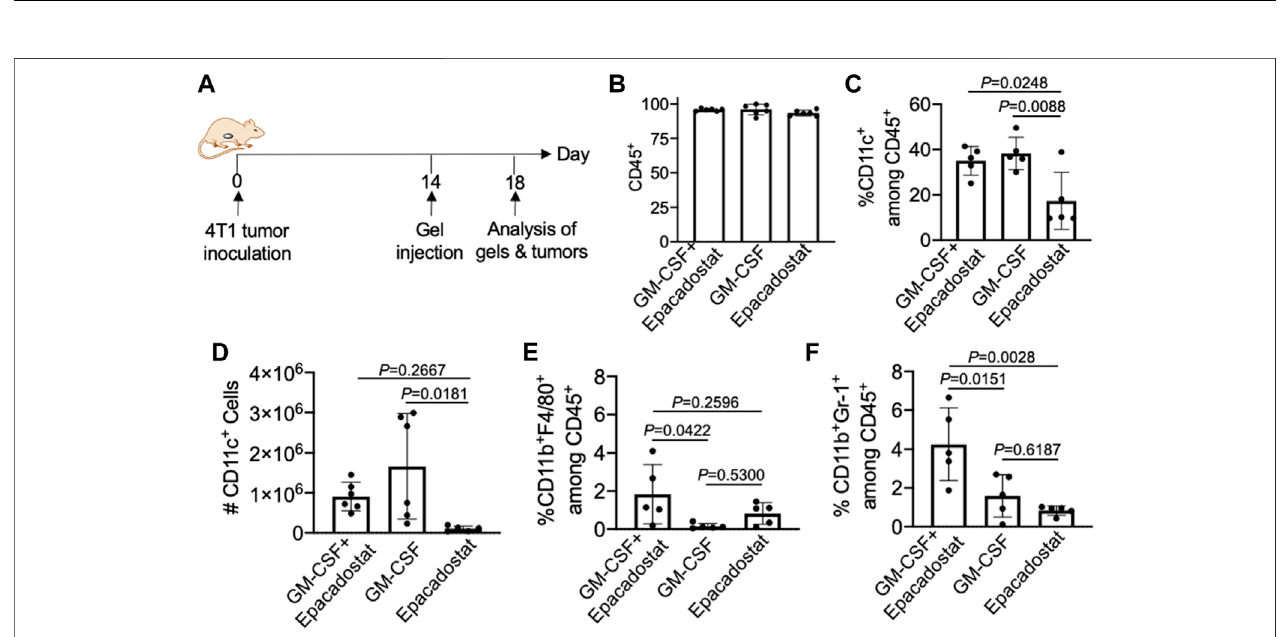
FIGURE 5 | Gels loaded with GM-CSF and epacadostat can recruit DCs in situ . (A) Timeframe of the in vivo study. Gels encapsulating GM-CSF and epacadostat, gelsencapsulatingGM-CSFalone,orgelsencapsulatingepacadostatalonewereinjectedadjacenttosubcutaneous4T1tumors. (B) PercentageofCD45 + cellsamong therecruitedcellsingels. (C) PercentageofCD11c + DCsamongCD45 + cellsingels. (D) NumbersofCD11c + DCsingels. (E) PercentageofCD11b + F4/80 + cellsamong the recruited cells in gels. (F) Percentage of CD11b + Gr1 + cells among the recruited cells in gels. All the numerical data are presented as mean ± SD (0.01 < * p ≤ 0.05; ** p ≤ 0.01; *** p ≤ 0.001).